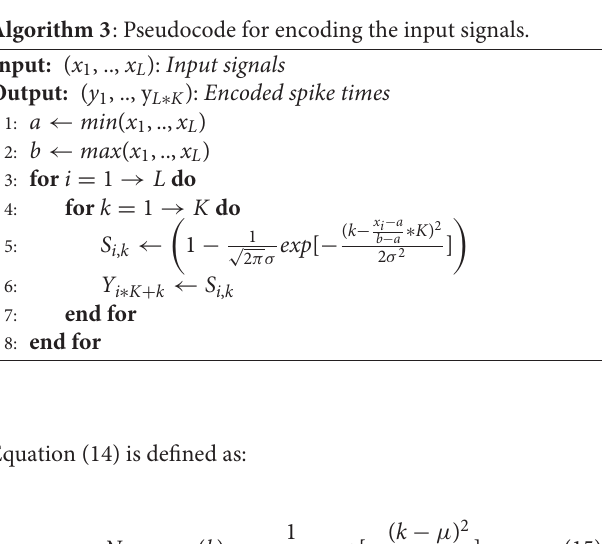
FIGURE 2 | Example of the unbalanced-input problem in SNNs. (A) Network structure. (B) Input-output spike times when i 3 i 3 1.3. Since we take the first activated output neuron as the network’s output, it cannot distinguish the two different input patterns in this example. When we = delayed i 3 from 1.0 (B) to 1.3 (C) , it only affected o 2 .